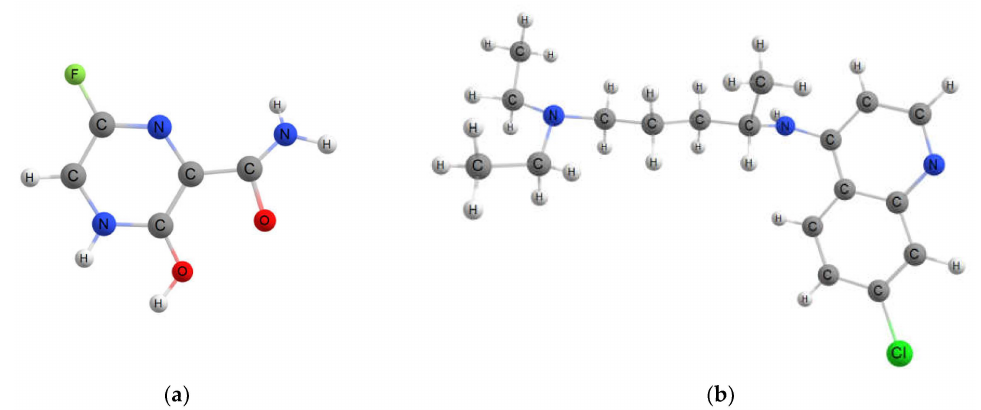
Figure 1. Chemical structures of ( a ) favipiravir and ( b ) chloroquine